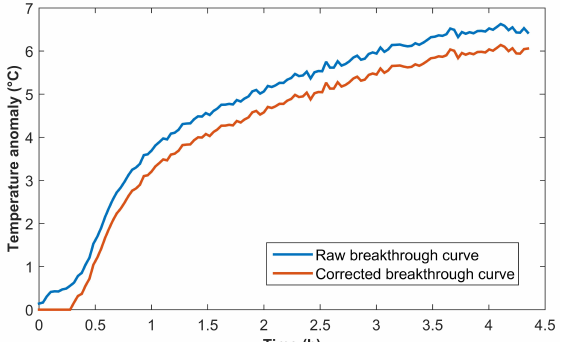
Figure 7. Thermal breakthrough curves measured at B3-1A depth during Experiment III before (blue) and after (red) removing the signal of heat losses coming from the injection